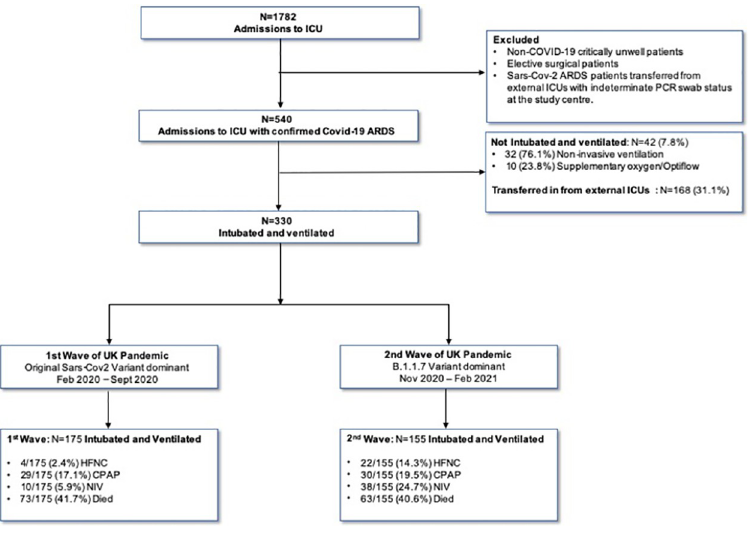
Fig 1. Study flow diagram demonstrating number of study patients during each wave. Number of patients receiving high flow nasal oxygen (HFNC), continuous positive airway pressure (CPAP) and non-invasive ventilation (NIV) prior to intubation also